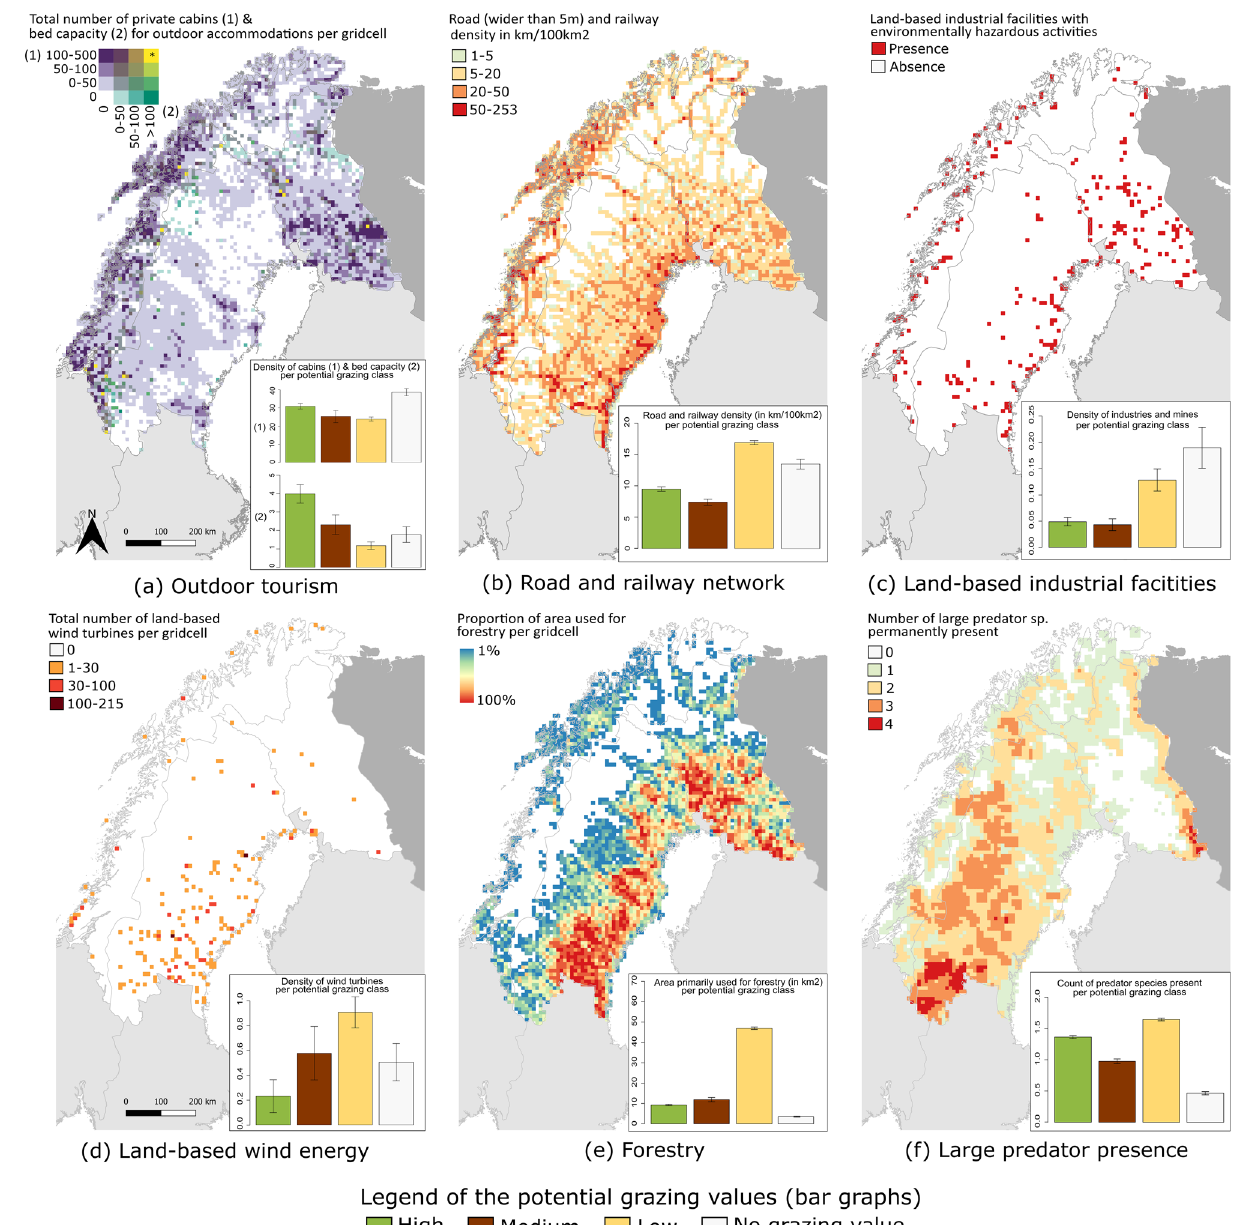
Figure 2. Maps over northern Fennoscandia depicting the ( a ) private cabins and outdoor tourism accommodations, ( b ) road and railway network, ( c ) land-based industrial facilities, ( d ) land-based wind energy, ( e ) the proportion of area primarily used for forestry, ( f ) the number of large predator species permanently present. For each map, the distribution of the pressure per potential grazing value is given with bar graphs. The error bars show standard errors. These maps were created with QGIS version 3.4.7, accessed on www. qgis. org. The country borders were from Eurostat ©EuroGeographics. *Note that, for Fig. 3a, for eight of the yellow grid cells, the total number of private cabins exceeds 500 and don’t contain any tourism